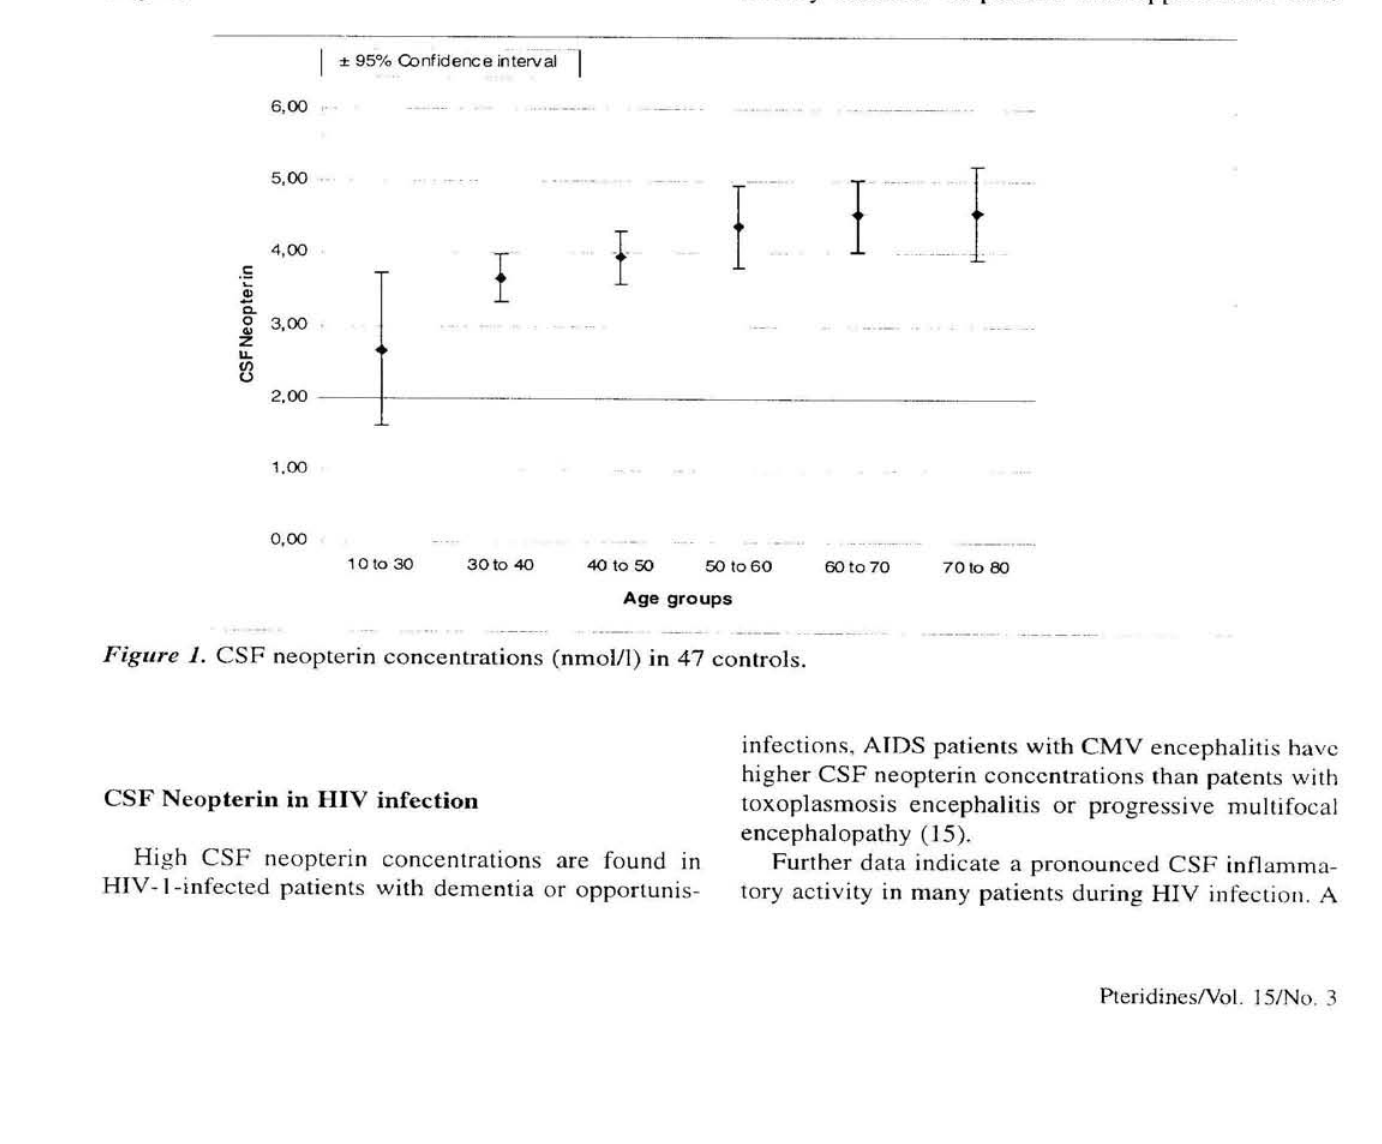
1. C SF neopterin concentrations (nmol/1) in 47 controls.